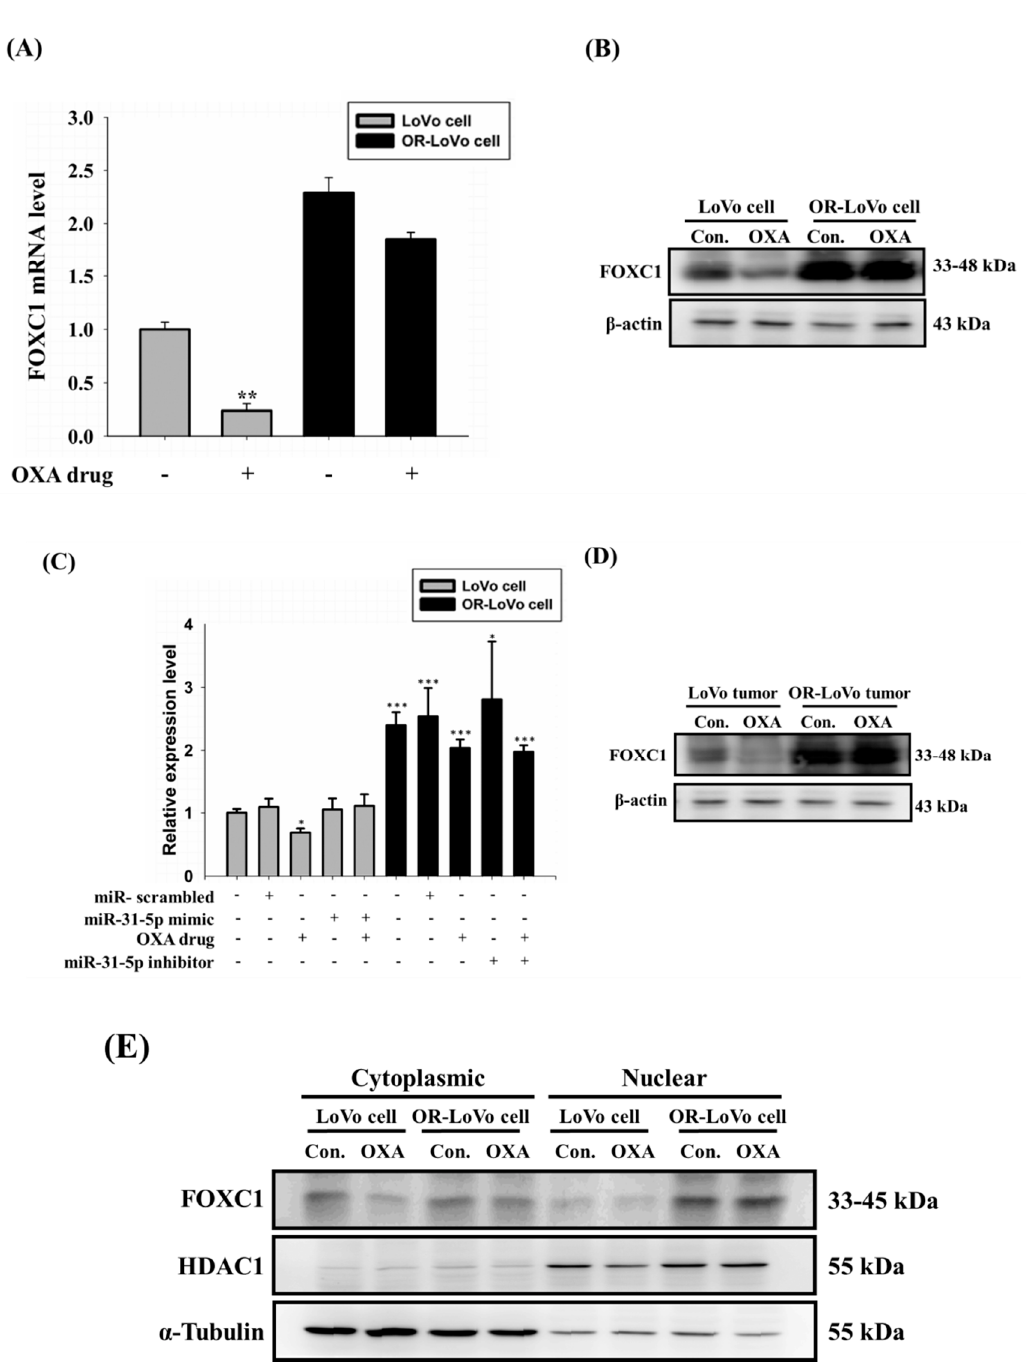
Figure 6. Experiments to identify the role of FOXC1 in colorectal cancer cells. ( A ) The FOXC1 mRNA level after treatment with or without OXA (45 μ M) in LoVo and OR-LoVo cells in vitro. ( B ) Protein expression of FOXC1 following treatment with or without OXA (45 μ M) in LoVo and OR-LoVo cells in vitro. ( C ) FOXC1 mRNA expression in the tumor formation assay in vivo. ( D ) Protein expression of FOXC1 following treatment with or without OXA in LoVo and OR-LoVo tumors in vivo. ( E ) FOXC1 nuclear translocation in LoVo cells and OR-LoVo cells in vitro. * p < 0.05 vs. LoVo cells control group; ** p < 0.01 vs. LoVo cells control group; *** p < 0.01 vs. LoVo cells control group.